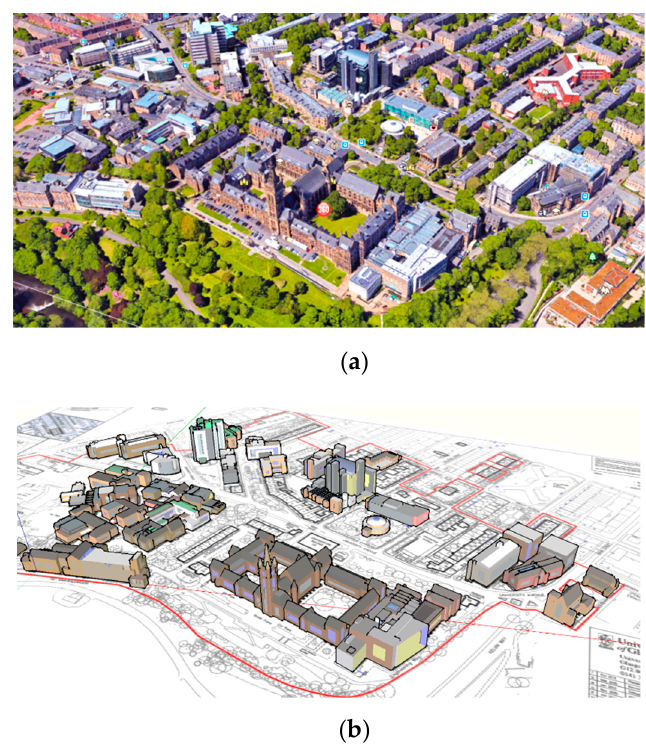
Figure 1. ( a ) The 3D satellite image obtained from Google global; ( b ) bottom-up model of buildings in a heating network built in SketchUp.